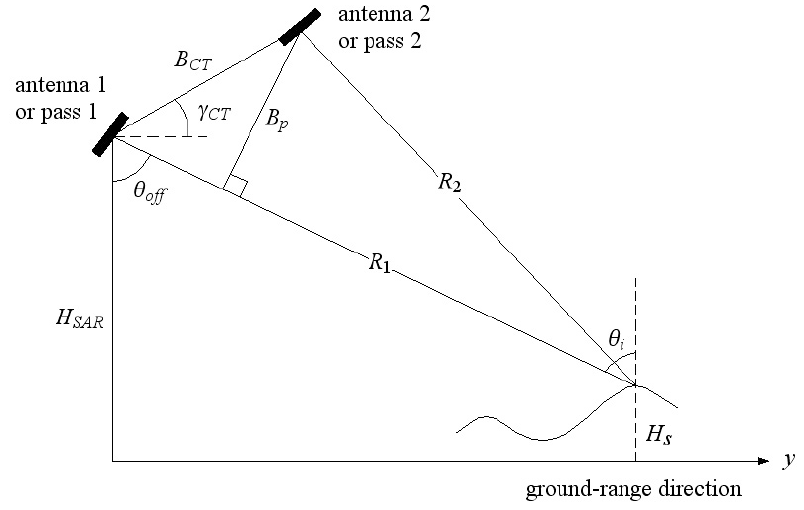
Figure 12. Geometry and parameters of CT (Cross-Track)-InSAR.